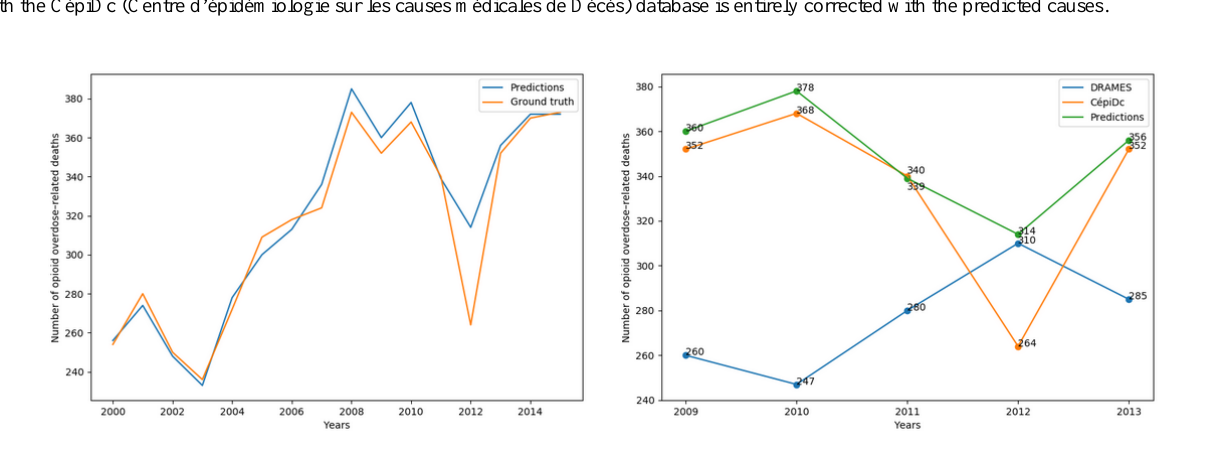
Figure 9. The left-hand plot shows the evolution of opioid overdose−related deaths from 2000 to 2015 in France, either coded with Iris and human coders (orange) or with the proposed approach (blue). The 2012 gap, although still present, is much smoother when using predicted underlying causes. The right-hand plot shows the comparison with DRAMES (Décès en Relation avec l’Abus de Médicaments Et de Substances) data. The contradiction with the CépiDc (Centre d’épidémiologie sur les causes médicales de Décès) database is entirely corrected with the predicted